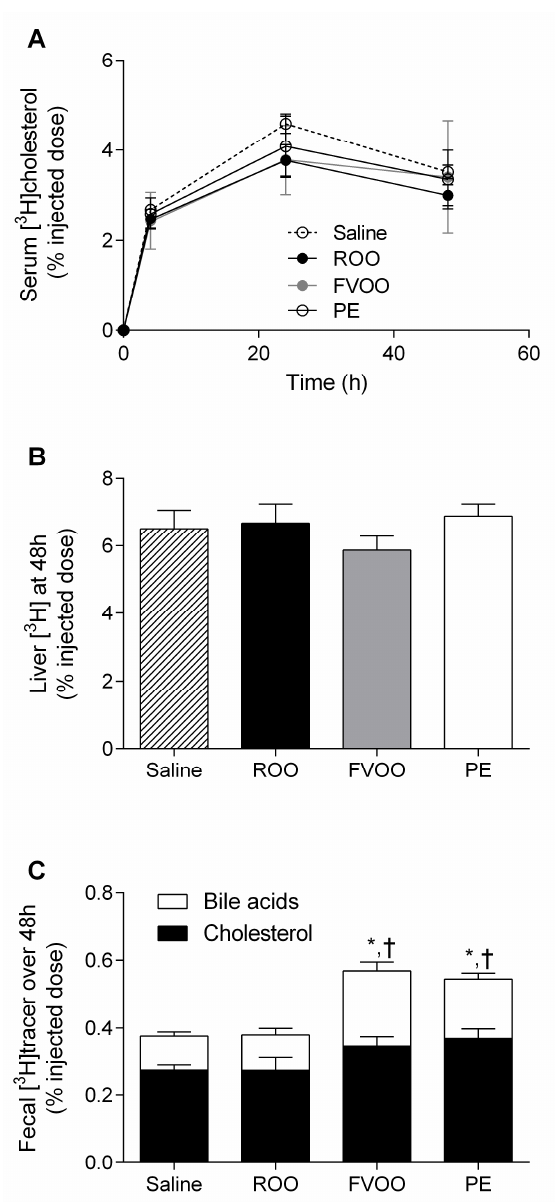
Figure 1. FVOO and its phenolic compounds promote macrophage-to-feces RevCT. ( A ) C57BL / 6 mice were administered intragastric doses of ROO, FVOO, PE, or the vehicle (saline) for 14 days. Individually-housed mice were intraperitoneally injected with [ 3 H]cholesterol-labeled J774A.1 macrophages, and serum [ 3 H]cholesterol was determined at the indicated times. ( B ) Liver [ 3 H]cholesterol was determined at 48 h. ( C ) [ 3 H]cholesterol and [ 3 H]tracer from fecal bile acids collected over 48 h. Values are the mean ± SEM of 10 mice in both saline and PE groups and 8 mice in both ROO and FVOO groups. * p < 0.05 vs. saline and † p < 0.05 vs. ROO.